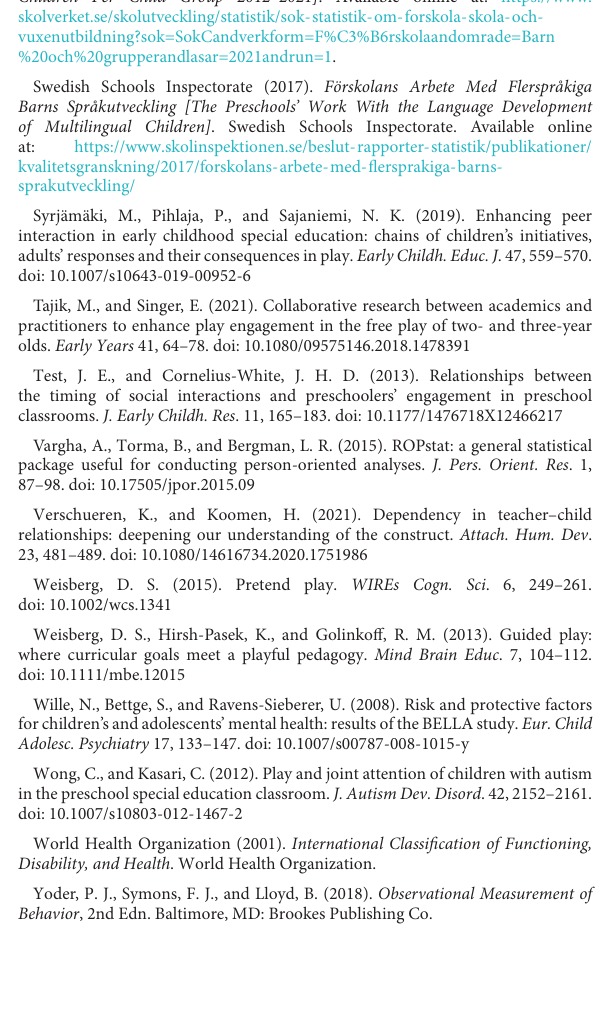
[Table 2A. Number of Enrolled Children, Preschool Units and Number of Children Per Child Group 2012–2021] . Available online at: https://www. skolverket.se/skolutveckling/statistik/sok-statistik-om-forskola-skola-och-